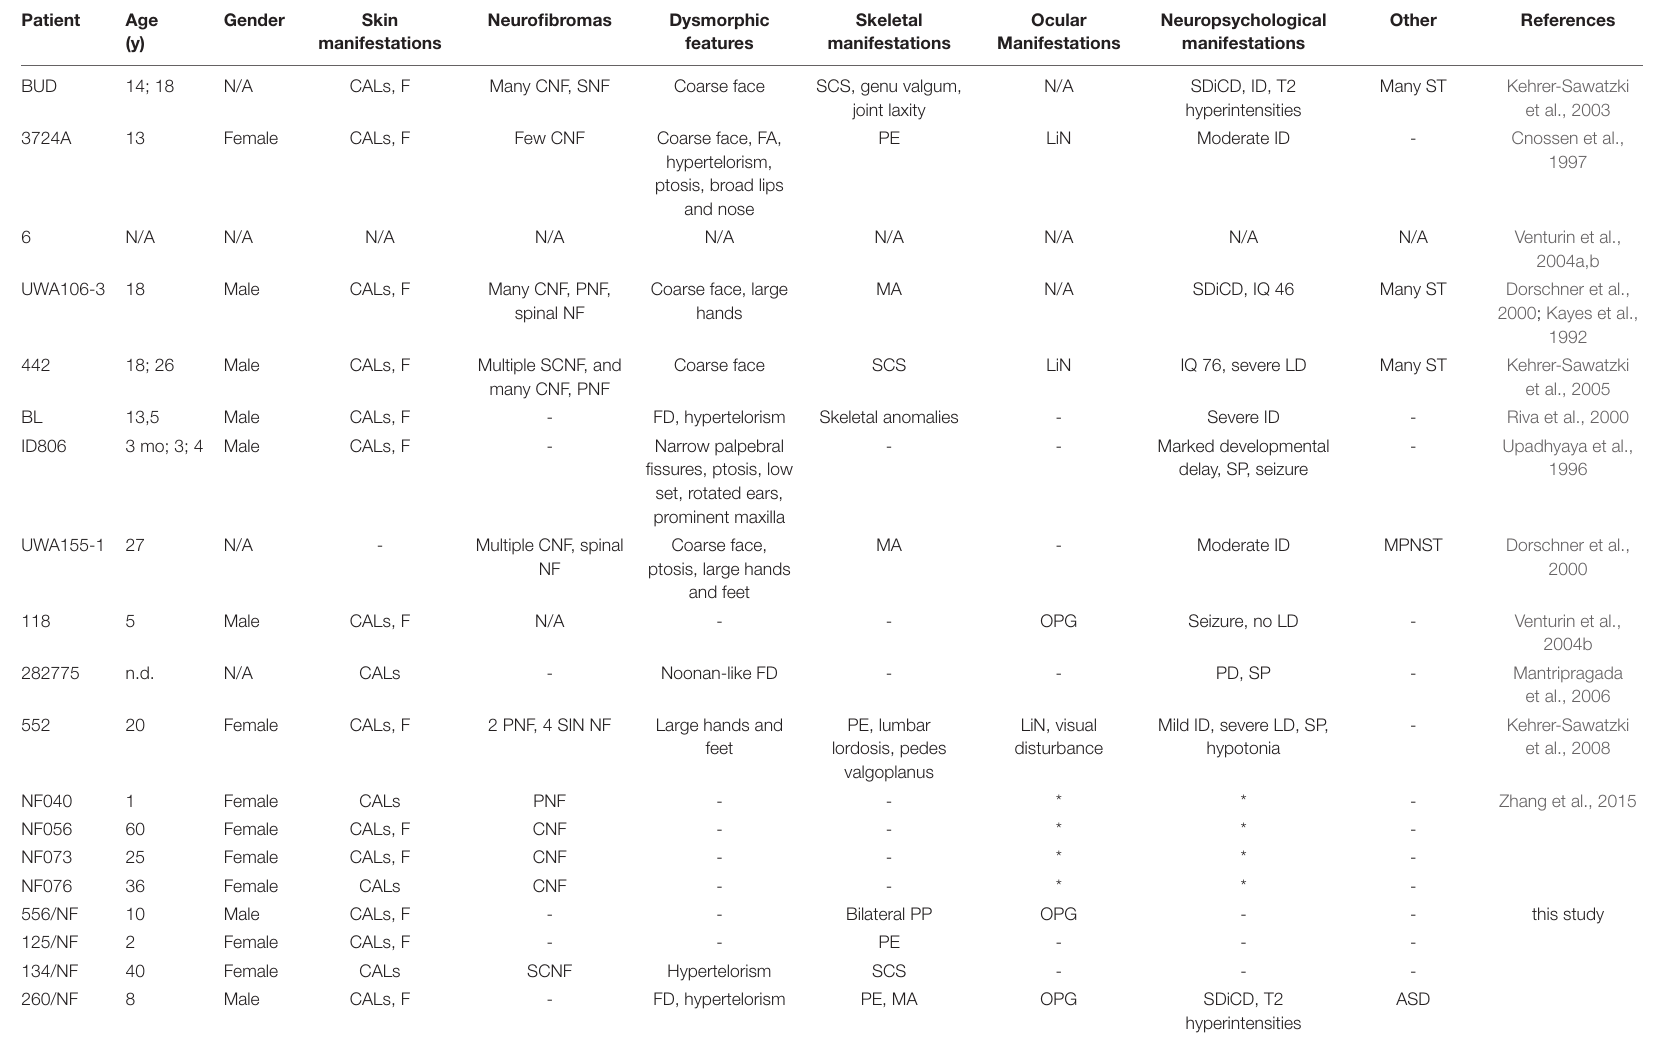
TABLE 4 | Clinical features of patients with atypical NF1 microdeletions.